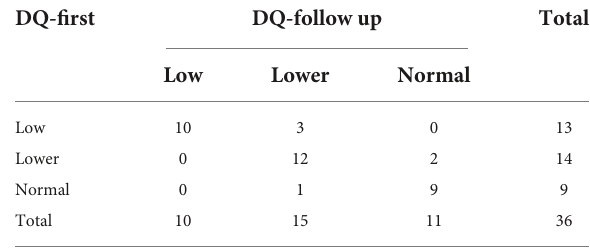
TABLE 5 Comparative analysis of blood examination before and after treatment in patients with cblC